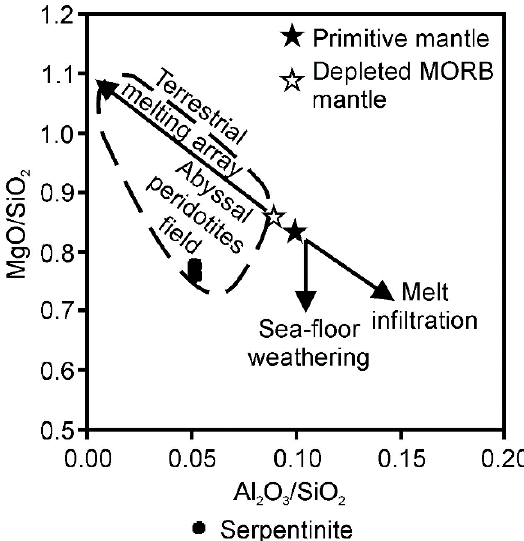
Figure 8. Serpentinite bulk-rock composition presented in terms of Al 2 O 3 /SiO 2 vs. MgO/SiO 2 . Diagram for abyssal peridotites based on De Hoog et al. [58], and references therein.